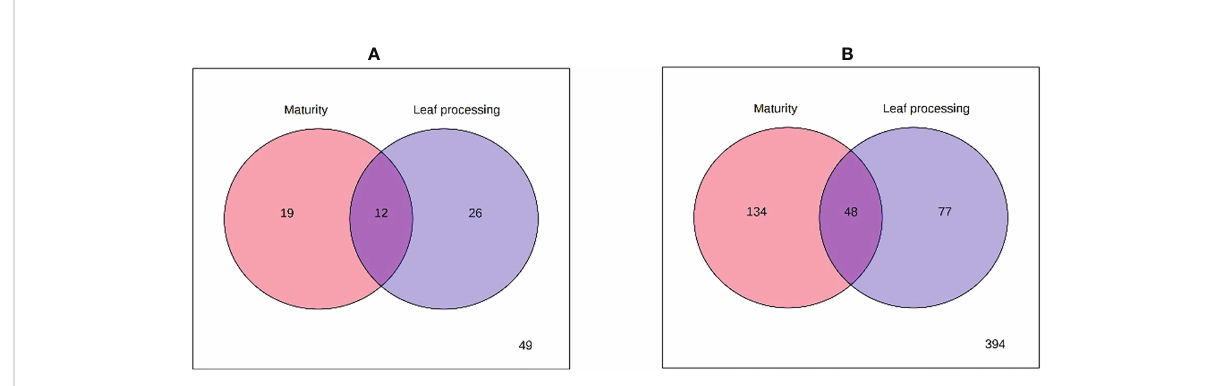
FIGURE 3 Venn diagrams of the results from two-way ANOVA of (A) GC-MS and (B) LC-MS analyses.